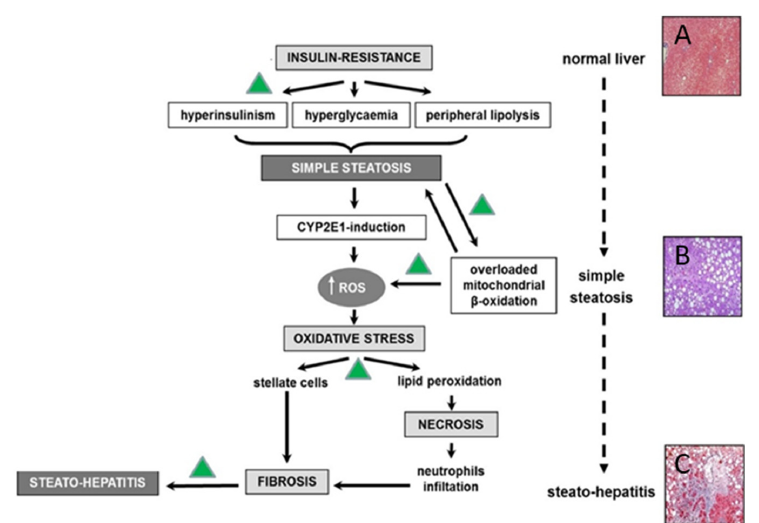
Figure 1. Pathogenic mechanisms involved in the progression of NAFLD and possible sites of polyphenols action (green triangles). (CYP2E1: Cytochrome P450 2E1, ROS: reactive oxygen species). ( A )Normal liver parenchyma is composed of small lobules of hexagonal shape with portal tracts at the apices; ( B ) hepatocytes contain one or more large fat droplets that displace the nucleus to an eccentric position; and( C ) ballooning degeneration of hepatocytes, scattered inflammation, and apoptotic bodies.